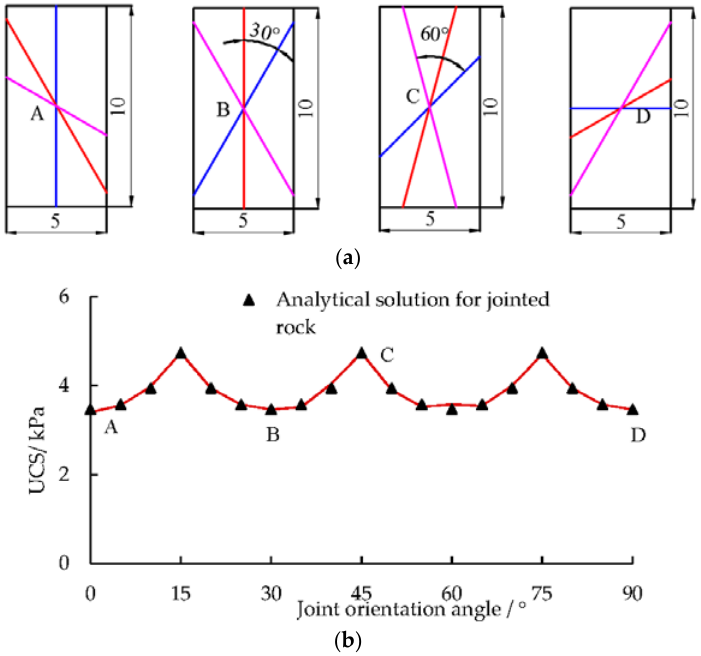
Figure 18. ( a ) Schematic diagram for samples with three joints; ( b ) UCS for sample with three joints: multi-joint model (line) and analytical solution (triangular) versus joint set angle.